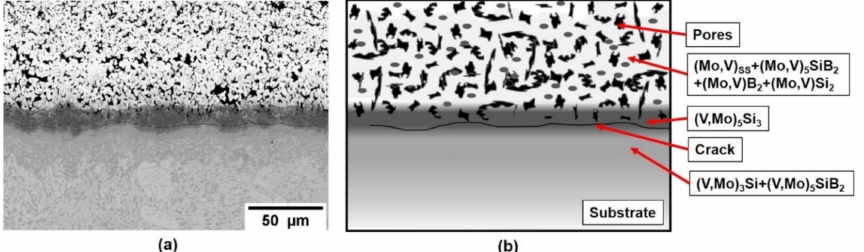
Figure 4. ( a ) Coating structure on a V-9Si-5B alloy after pack cementation at 1000 ◦ C for 50 h in flowing Ar and ( b ) schematic illustration of the as-packed structure.